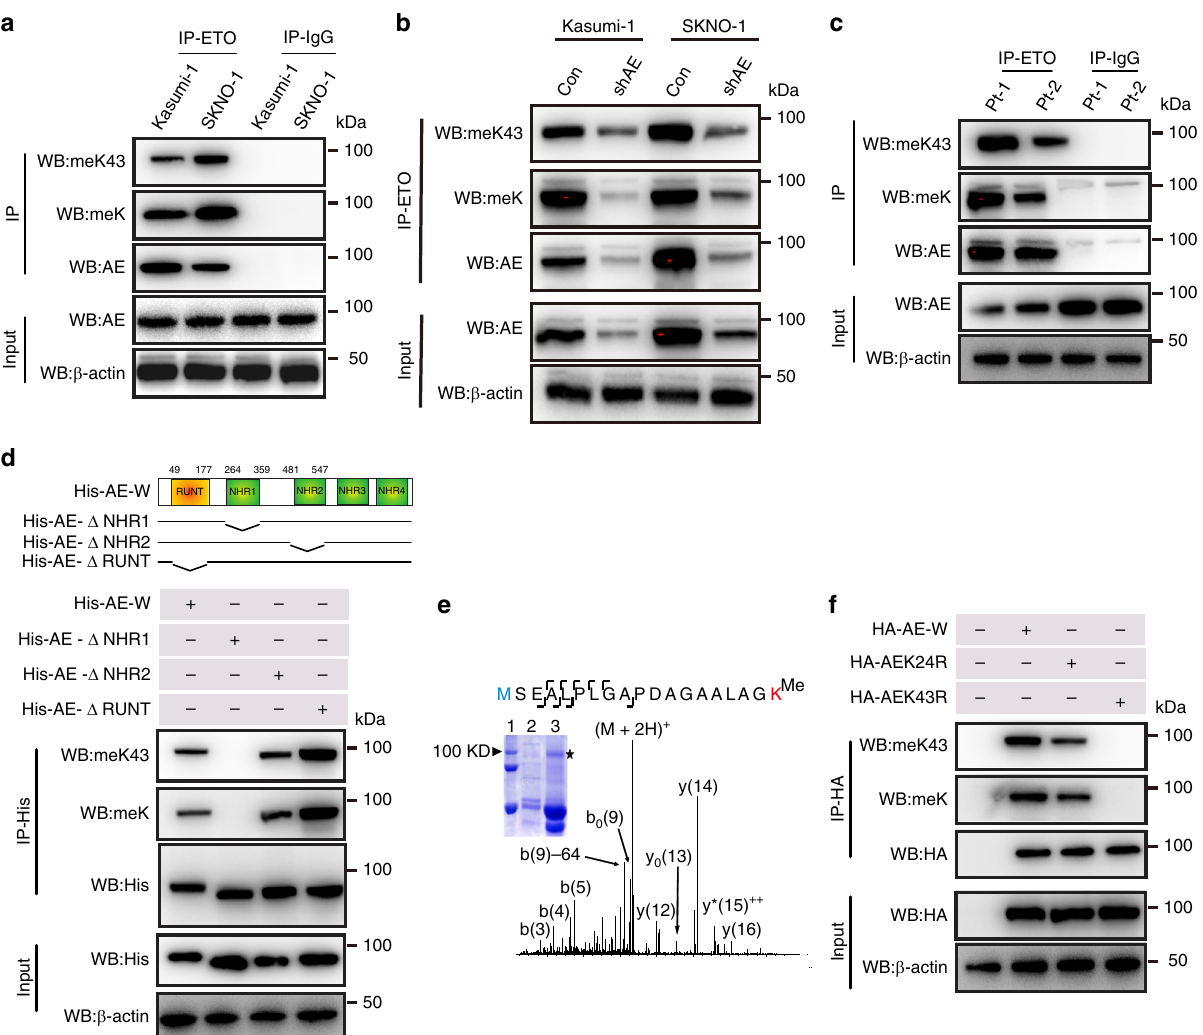
Fig. 2 AML1-ETO is methylated at Lys43 in vitro and in vivo. a Western blotting for anti-ETO immunoprecipitates (lanes 1, 2) from Kasumi-1 and SKNO-1 cells. IgG pull-down performed in parallel (lanes 3, 4) was used as a negative control. b Kasumi-1 and SKNO-1 cells were transfected with AML1-ETO shRNA (shAE) for 48 h. The anti-ETO immunoprecipitates (IP) and total cell lysates (Input) were subjected to Western blotting. c Western blotting for anti-ETO immunoprecipitates (lanes 1, 2) from AML1-ETO-positive patient primary cells ( N = 2). IgG pull-down performed in parallel (lanes 3, 4) was used as a negative control. Pt patient. d Upper: Diagram of AML1-ETO domain constructs; lower: Western blotting for anti-His immunoprecipitates from HEK293 cells expressing His-AE-W (wild type) (lane 1), His-AE- Δ NHR1 (lane 2), His-AE- Δ NHR2 (lane 3) or His-AE- Δ RUNT (lane 4). e The MS/MS fragmentation spectrum and pattern of the isolated peptide MSEALPLGAPDAG AALAGK. AML1-ETO was immunoprecipitated by anti-ETO from Kasumi-1 cells. (Inset) SDS-PAGE of precipitated proteins con fi rmed AML1-ETO pulldown (Coomassie blue-stained) in Kasumi-1 (lane 2) and HEK293 cells (lane 3). Lane 1 is the protein ladder marker. The AML1-ETO bands from the anti-ETO IP (indicated by star) were subjected to LC/MS/MS. The b-type and y-type product ions are marked in the spectrum. A 14 Da increase in the Lys43 residue was observed, which indicated a mono-methylated lysine residue. f Western blotting for anti-HA immunoprecipitates from HEK293 cells expressing HA-AE-W (lane 2), HA-AEK24R (lane 3), or HA-AEK43R (lane 4). IP Immunoprecipitation, WB Western blotting; AE AML1-ETO. The “ Input ” of each Fig is the immunoblot analysis for whole cell extracts to show the target protein levels. meK43: our anti-AML1-ETO Lys43 antibody; meK: commercial lysine methylation antibody. The data are representative of 3 independent experiments. Source data are included in the Source Data fi